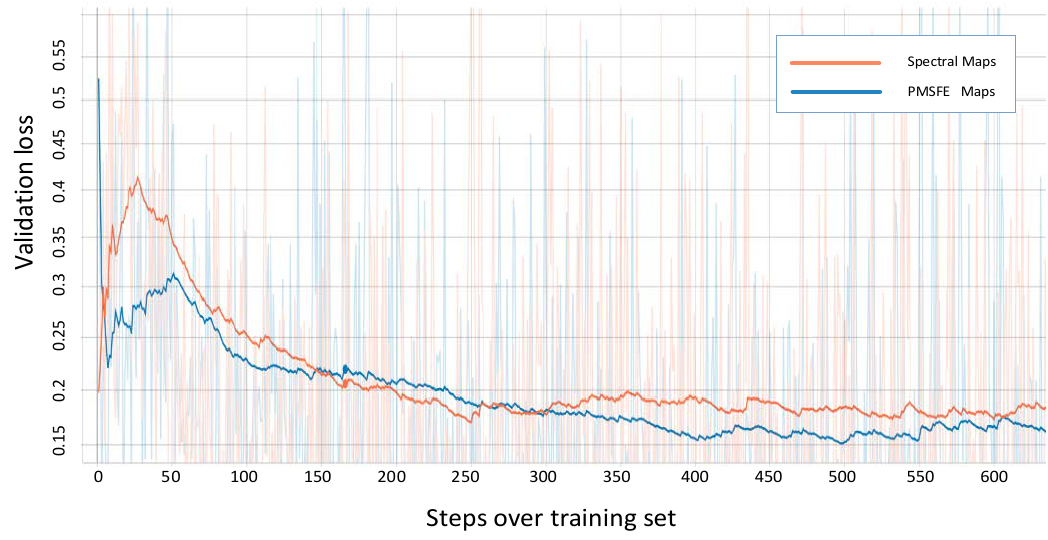
Figure 7. Validation loss of spectral maps and PMSFE maps over the training set in VGGNet-19 (Smooth = 0.97 in Tensorboardx).